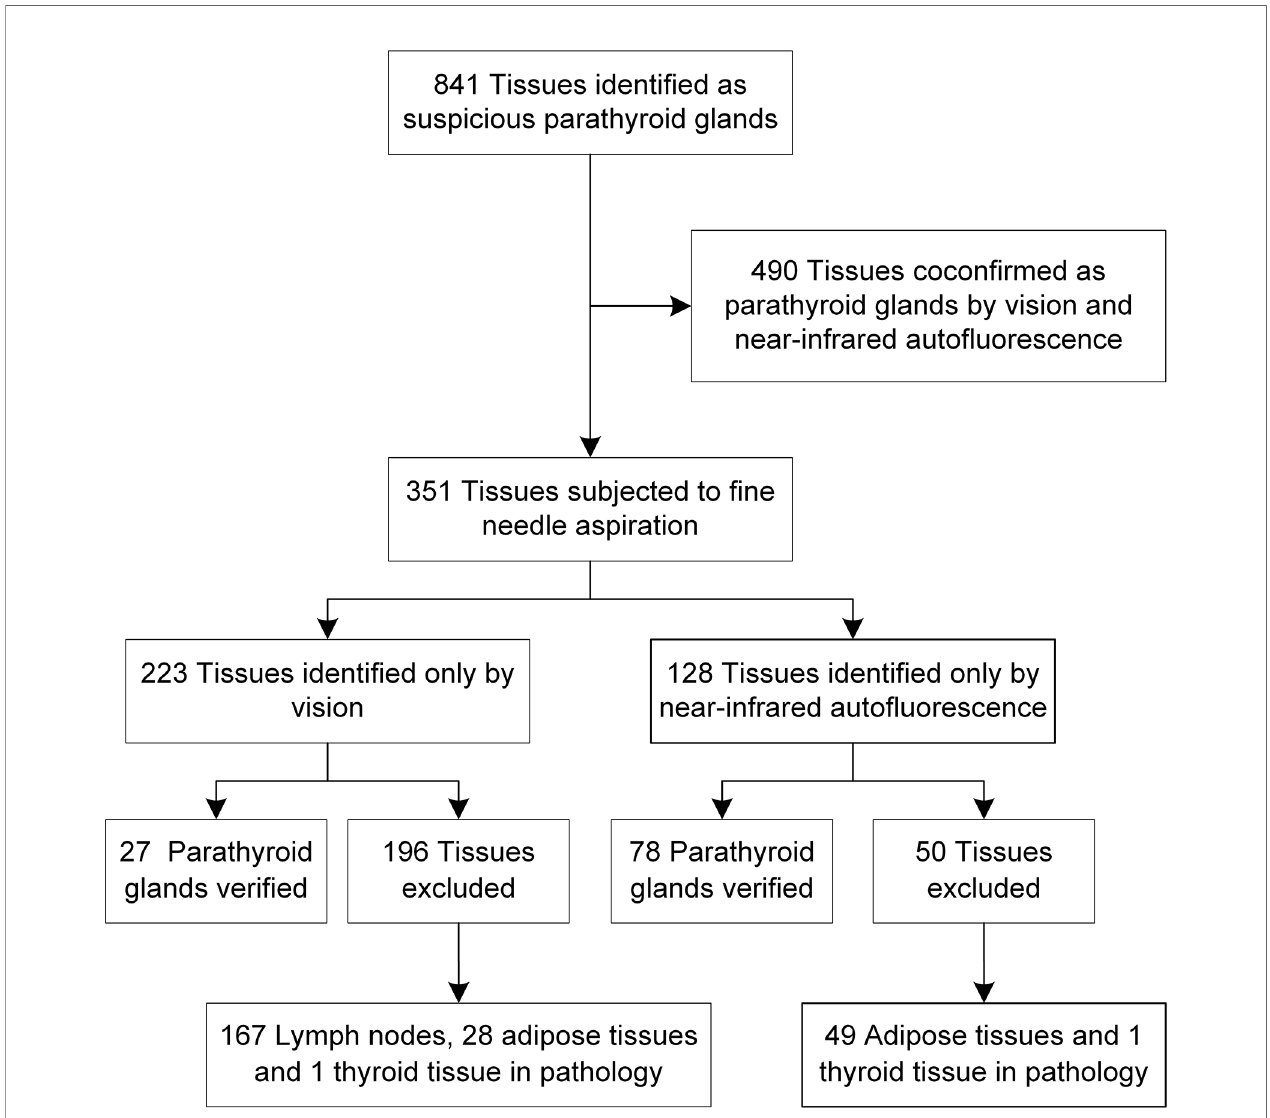
FIGURE 2 | The veri fi cation process of 841 suspicious parathyroid